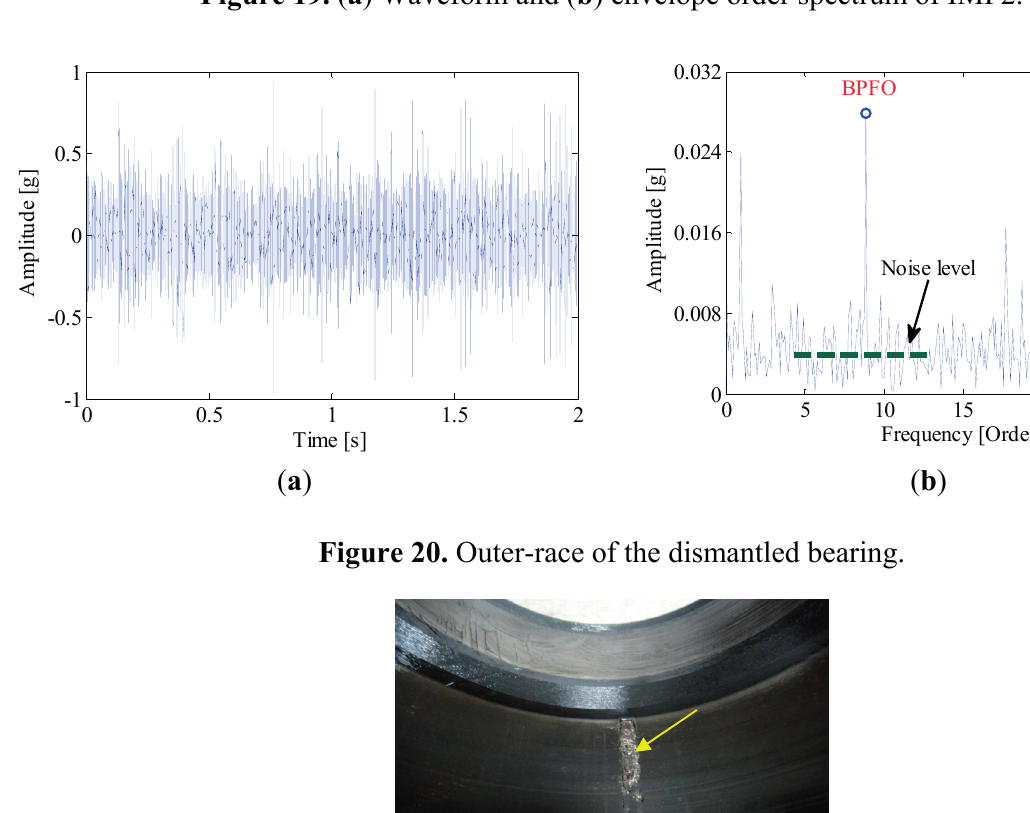
Figure 19. ( a ) Waveform and ( b ) envelope order spectrum of IMF2.